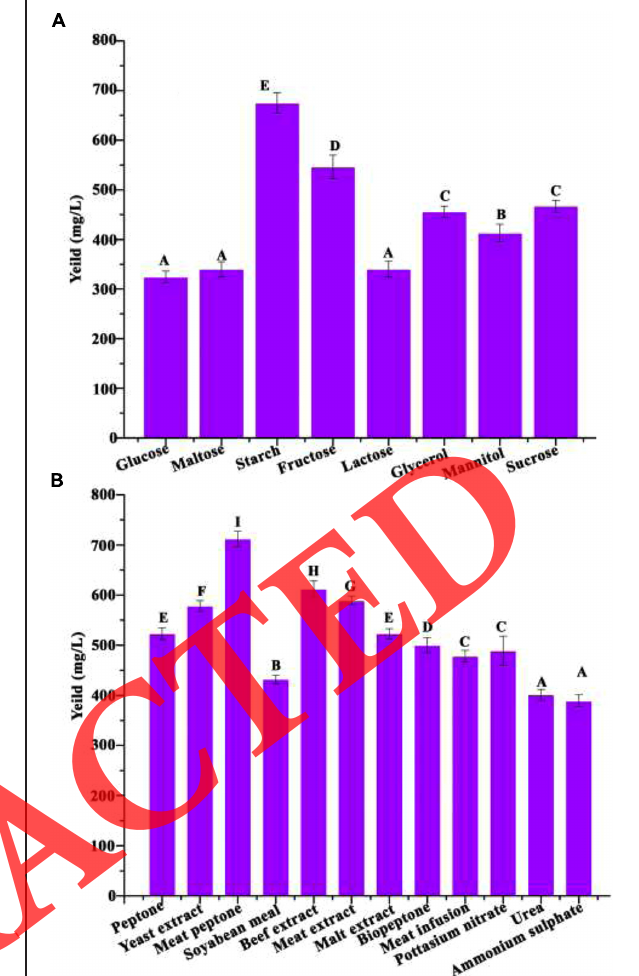
FIGURE 4 | Yield of crude extract in TBS media supplemented with different carbon sources and nitrogen sources. (A) Carbon sources and (B) nitrogen sources. Different letters in the superscript were significantly different according to Duncan’s multiple range test ( p < 0.05).